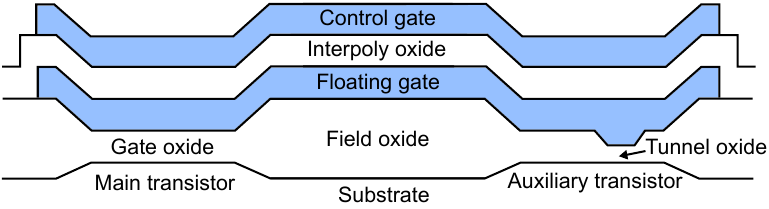
Figure 7. Illustration of the EPAD structure